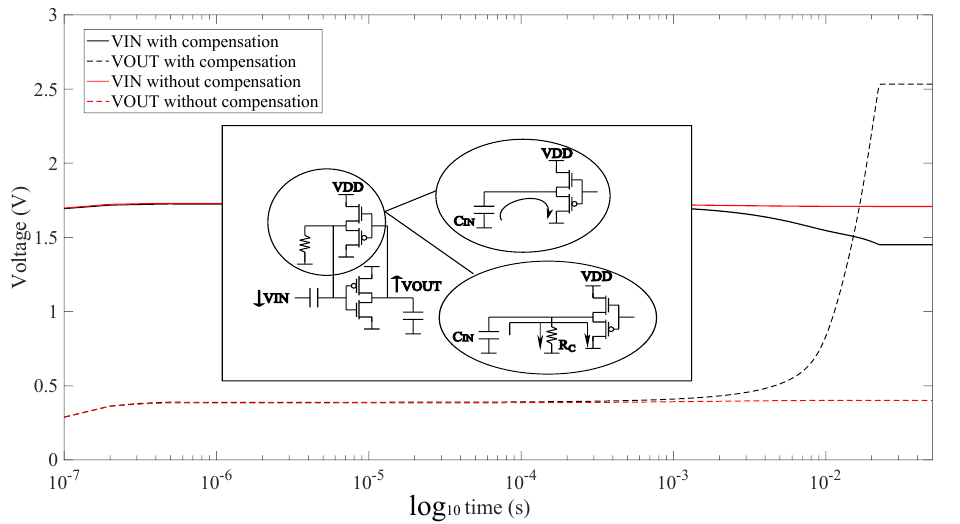
Figure 9. Feedback reaction analysis led by the PMOS in the voltage buffer. The feedback reaction starts from an initial condition of V IN = V DD , V OUT = 0 V.